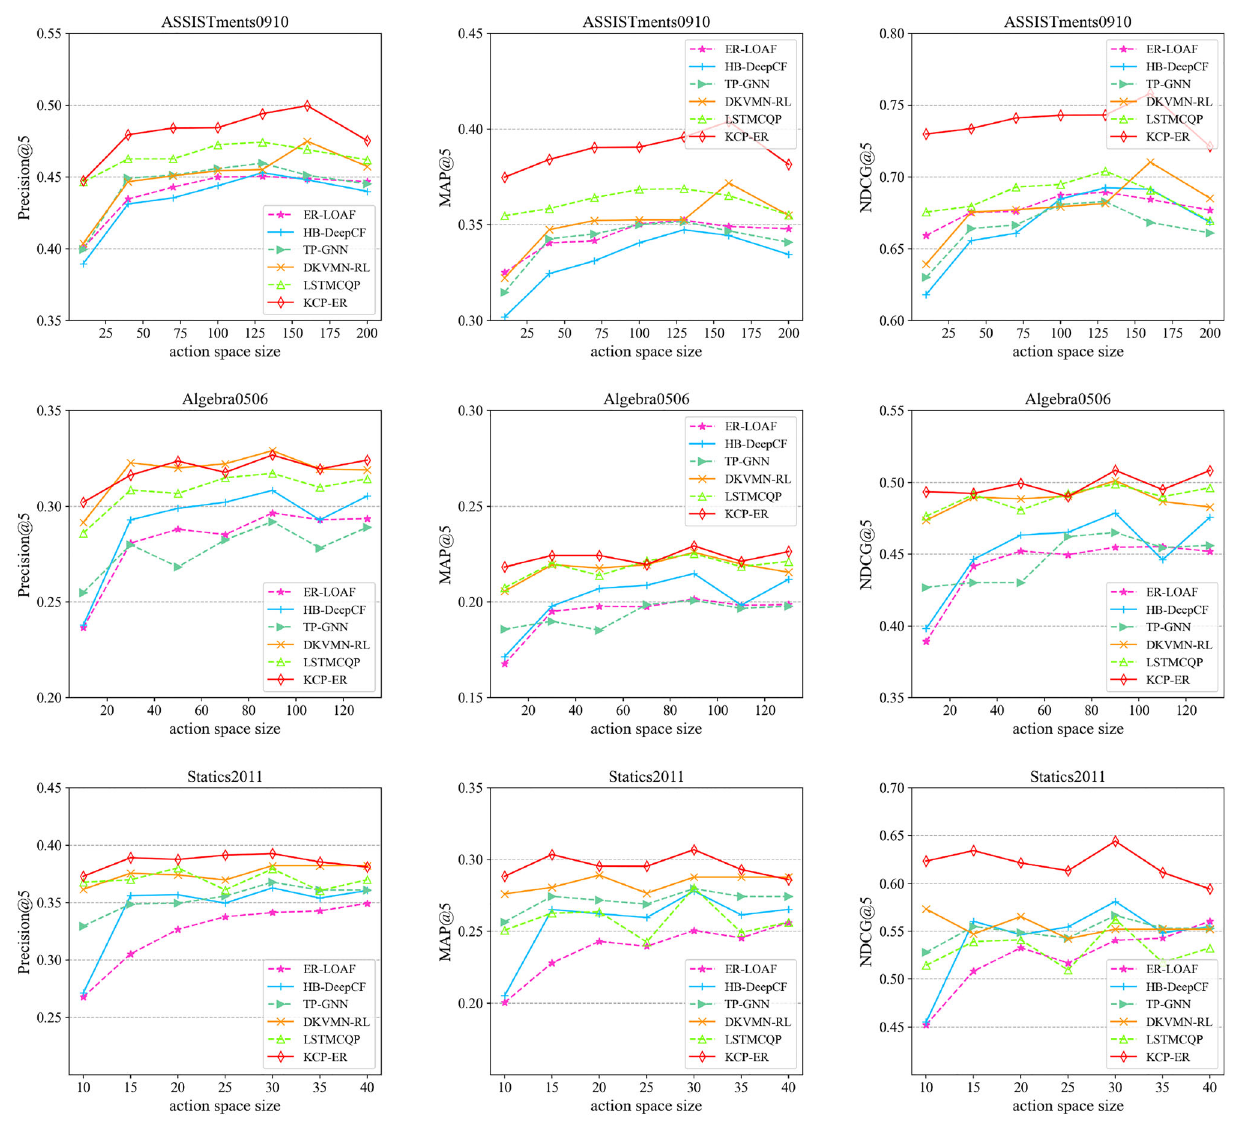
Fig. 5 Recommendation performance of TERD with action space size on three